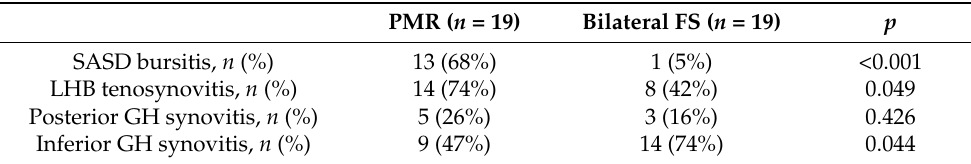
Table 3. Bilateral synovial pathologies in patients with PMR and bilateral FS.